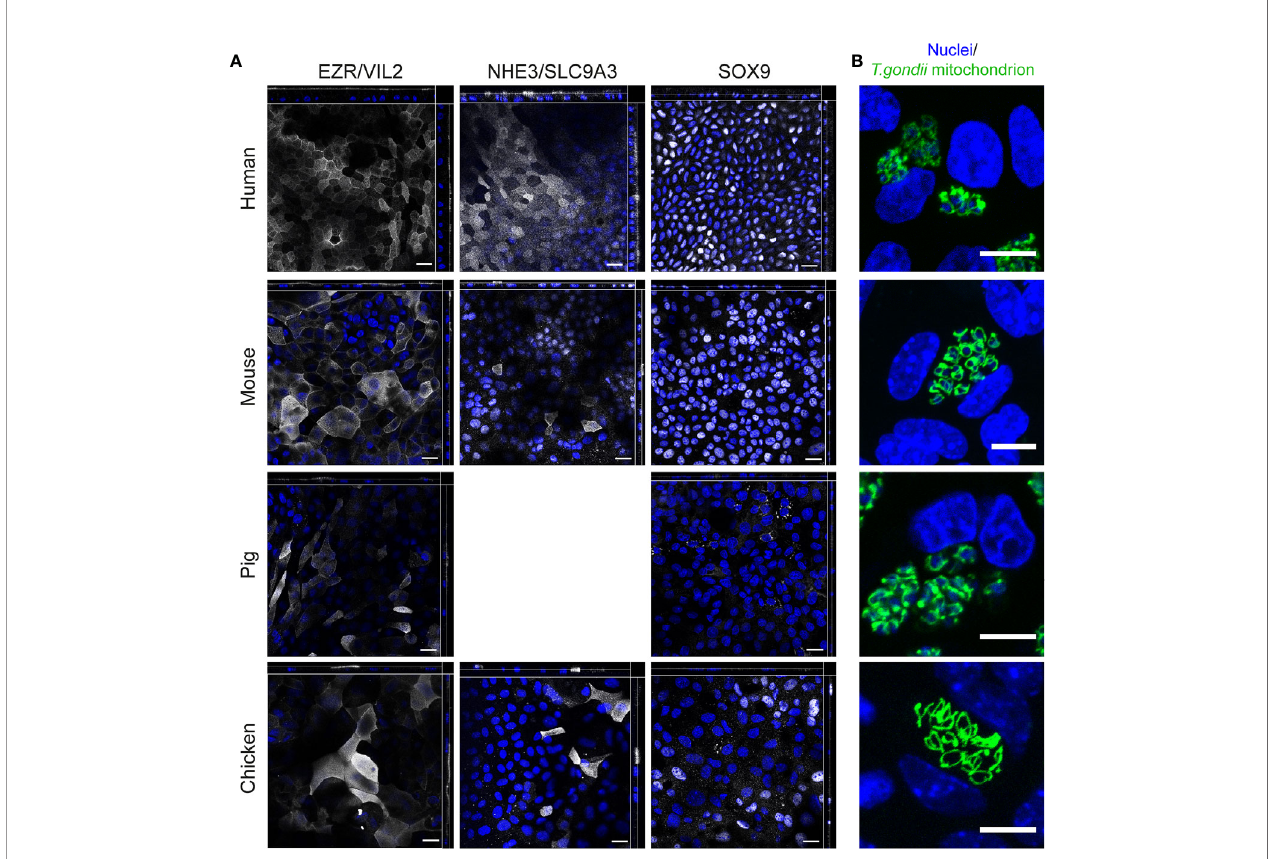
FIGURE 5 | Immuno fl uorescence analysis of ODMs from human, mouse, pig and chicken origin. (A) Orthogonal stacks for brush border protein EZR, enterocyte marker NHE3, and SOX9. ODMs were cultured as described and fi xed after 10 (human), 12 (mouse), 6 (pig) and 15 (chicken) days. Note, NHE3 analysis for pig was excluded as suitability of the antibody for IFA staining in this species is questionable (see Supplementary Figure 6 ). Suitability of the SOX9 antibody for IFA staining for pig is also questionable, however, the analysis was included as the antibody target sequences are highly similar between species (see Supplementary Figure 6 ). Representative fl uorescent orthogonal stacks of ODMs are shown. Scale bars represent 20 µm. (B) Representative confocal image projections of ODMs infected for 48 h with T. gondii (distinguished by its GFP-tagged green tubular mitochondria) in TYI-S-33 medium. Scale bar 10µm. All experiments were performed at least twice with similar